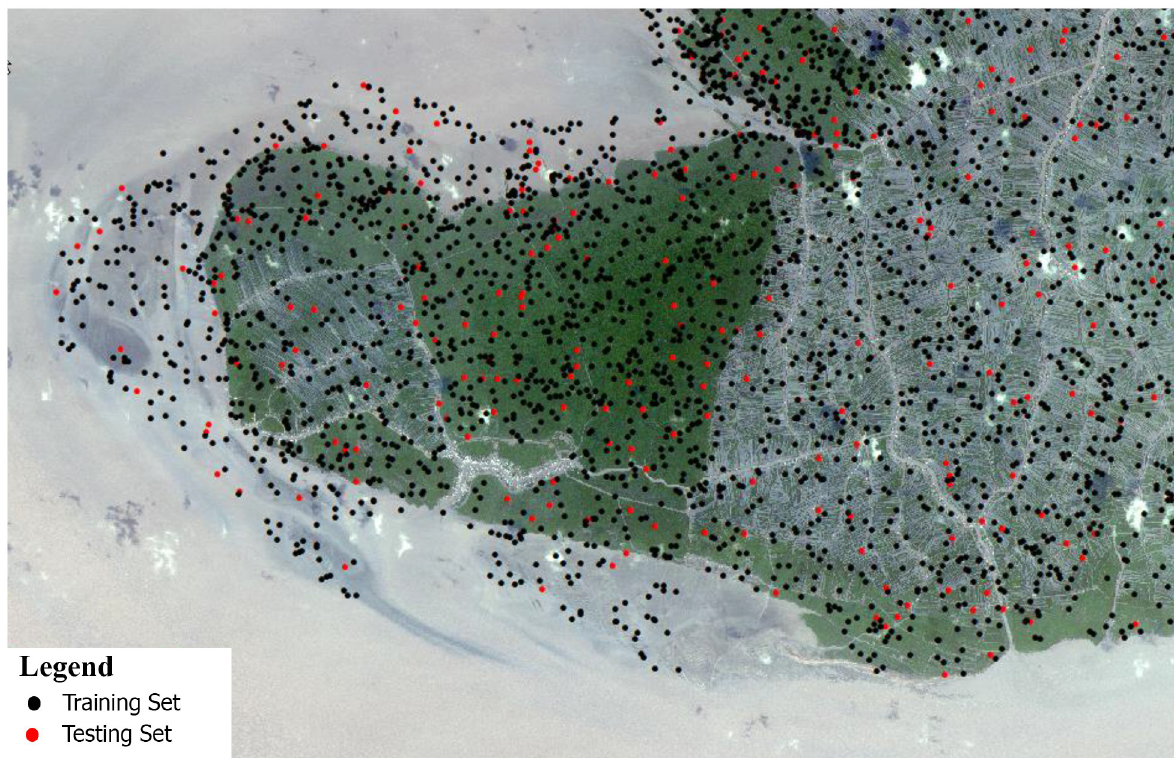
Fig 5. Sample collection for the random forest algorithm input (republished satellite data under a CC BY license, with permission from the Department of Remote Sensing, Ministry of Natural Resources and Environment of Vietnam, original copyright [1995, 2004, 2015]).